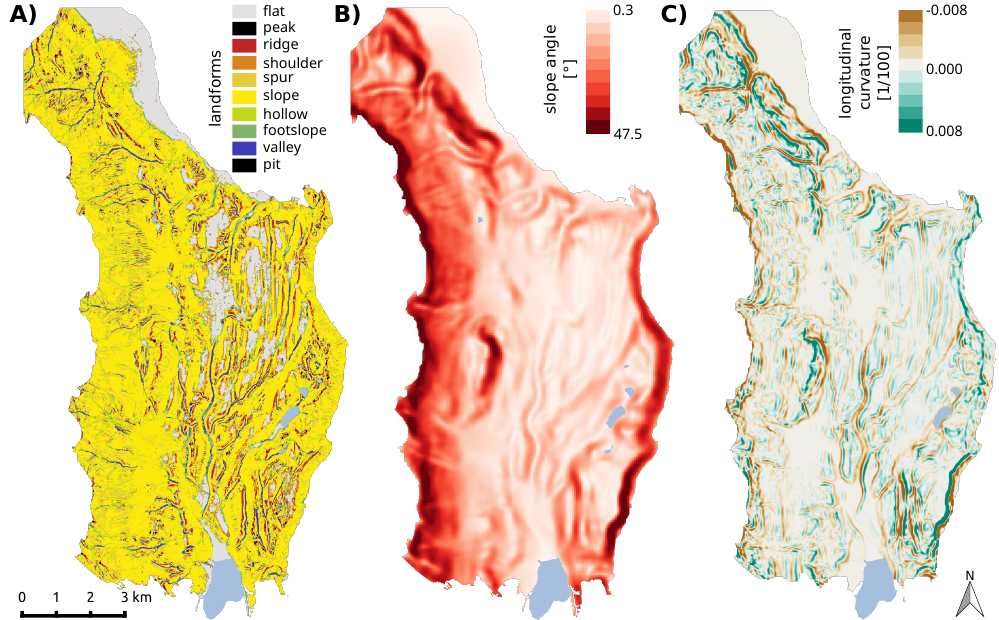
Figure 3. Three exemplary terrain parameters and landform maps used in the study. ( A ) Landforms calculated with r.geomorphon at a grid cell size of 10 m, search radius of 100 m and flatness threshold of 4 ◦ . ( B ) Slope at a grid cell size of 50 m and a search window of seven cells. ( C ) Longitudinal curvature at a grid cell size 10 m and a search window of 15